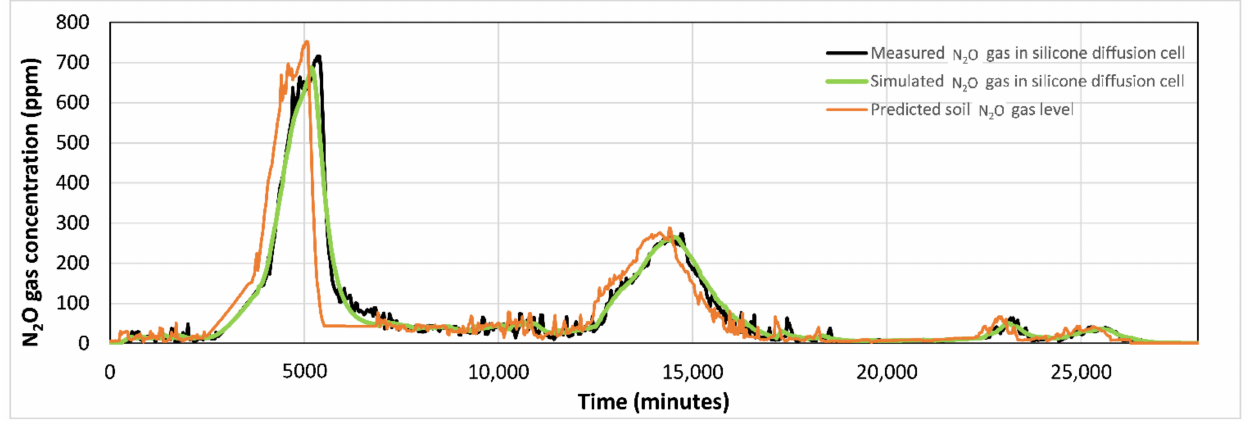
Figure 9. Temporal variations in measured and simulated N 2 O gas levels in the silicone diffusion cell with predicted soil gas levels for experiment